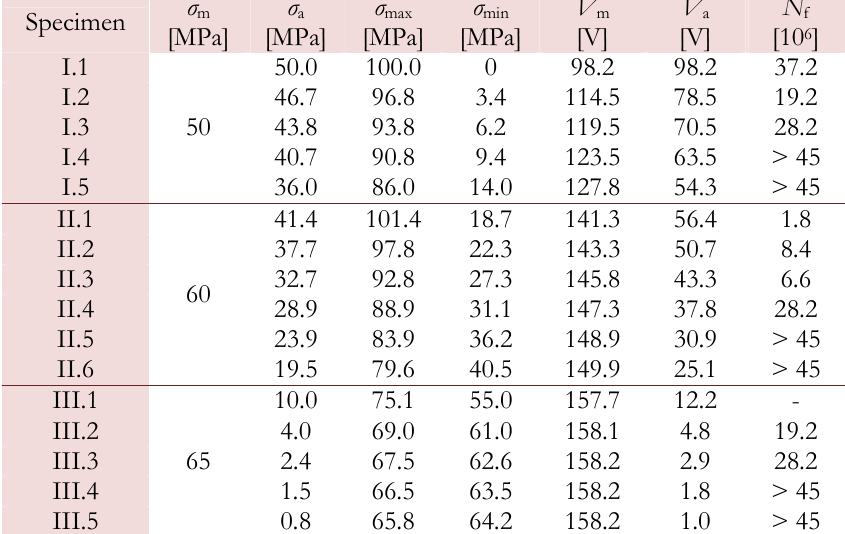
Table 4: Stress levels and actuation voltages used for tensile